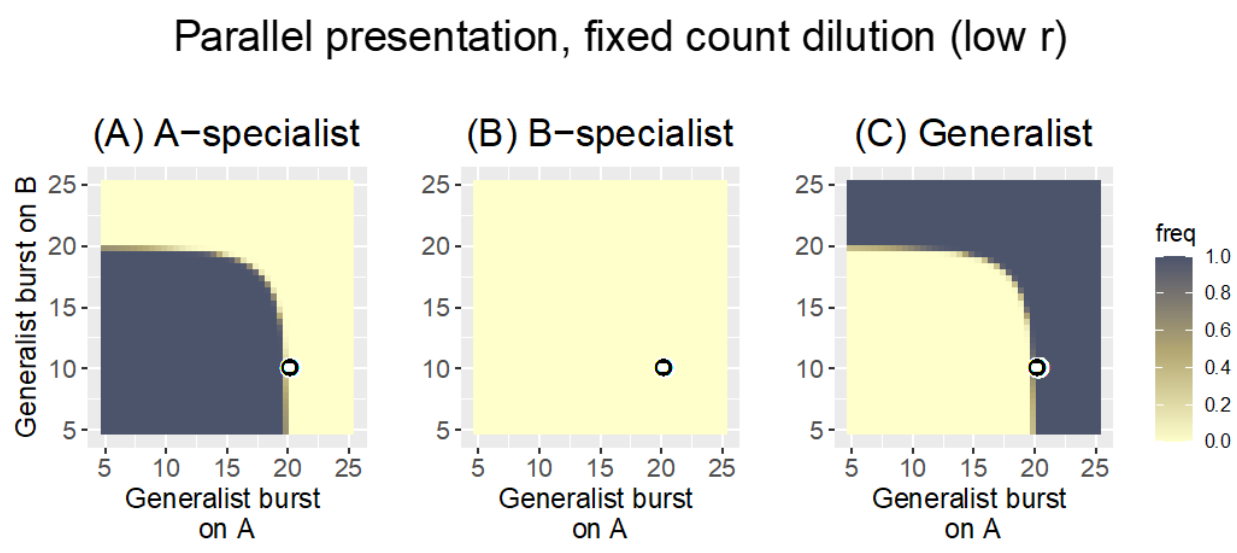
Figure 4. Heat maps of Parallel presentation with unequal burst sizes of the two specialists ( b A|A = 20, b B|B = 10, as indicated by the black-on-white ring). The three panels show the frequency of the A-specialist ( A ), the B-specialist ( B ), and the generalist ( C ). The trial conditions are the same as in Figure 3 except that the bacterial growth rate has been lowered to r = 0.1. With this change, the pattern is radically different from before (Figure 3). Now, only one phage is ever maintained, and the B-specialist is lost everywhere. Although the specialist burst sizes are unequal, the pattern of phage maintenance is symmetric, the A-specialist being the only phage maintained up to the point that the generalist burst on either host exceeds 20 (20 is the burst size of the A-specialist). As in Figure 3, dilution reduces phage density to 1000 every 20 time steps. The key is the same as in Figures 2 and 3.